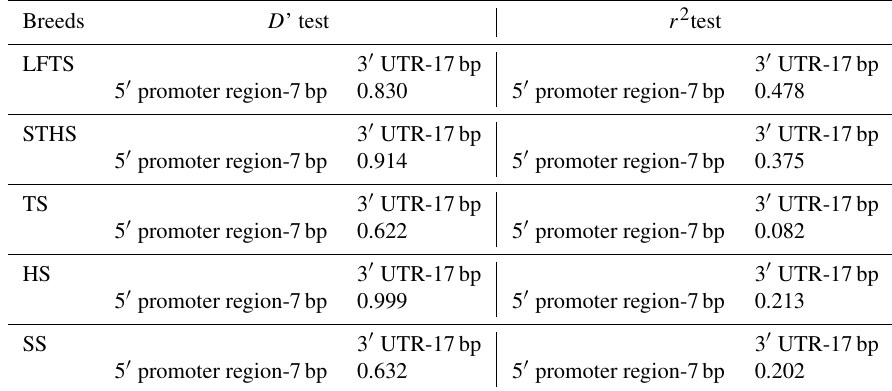
LFTS TS 165 0.261 0.400 0.339 0.461 HS 189 0.238 0.656 0.106 SS 138 0.297 0.507 0.196 0.551 0.449 P> 0 . 05